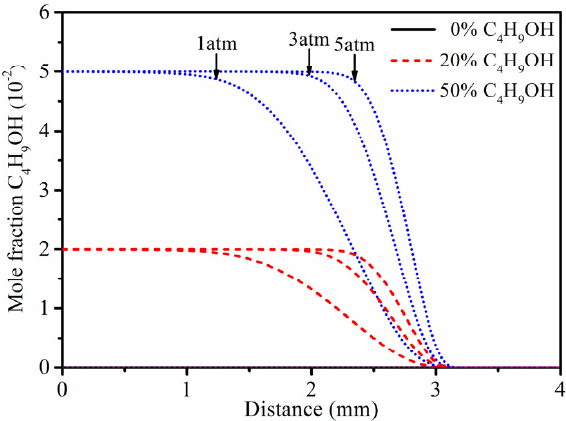
Figure 4. Mole fractions of C 4 H 9 OH, with different levels of n -butanol at different pressures.